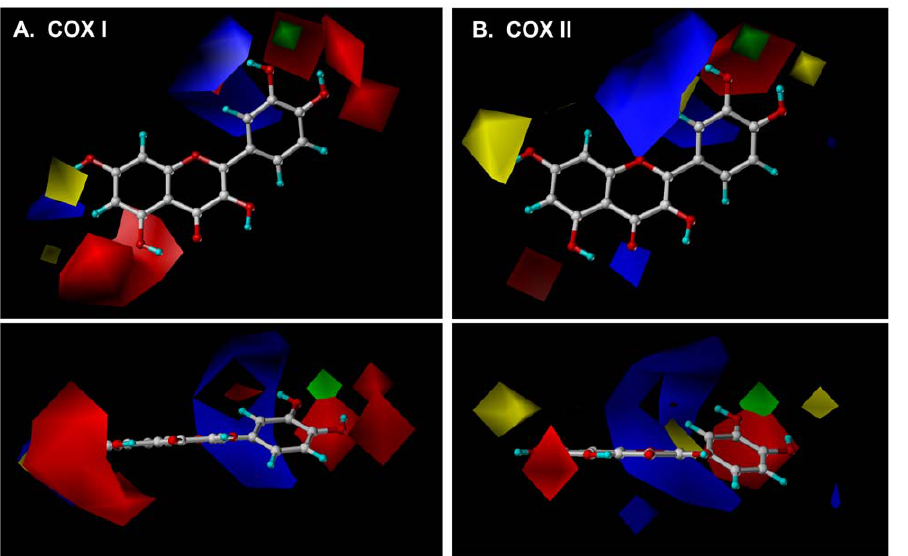
Figure 3. The 3-D QSAR/CoMFA color contour maps for COX I (A) and COX II (B). Note that quercetin was shown in the ball and stick format inside the field for demonstration. Oxygen, carbon, and hydrogen atoms are colored in red, gray, and blue, respectively. The contours of the steric maps are shown in yellow and green, and those of the electrostatic maps are shown in red and blue. Green contours indicate regions where a relatively bulkier substitution would increase the COX activity, whereas the yellow contours indicate areas where a bulkier substituent would decrease the COX activity. The red contours are regions where a negative-charged substitution likely would increase the COX activity whereas the blue contours showed areas where a negative-charged substitution would decrease the COX activity. Bioflavonoids with a higher ability to activate the COX enzymes are correlated with: ( i ) more bulkier substitute near green; ( ii ) less bulkier substitute near yellow; ( iii ) less negative charge near blue; and/or ( iv ) more negative charge near red. The figure in the lower panel shows the 90 u rotation around the x -axis of the figure shown in the upper panel.